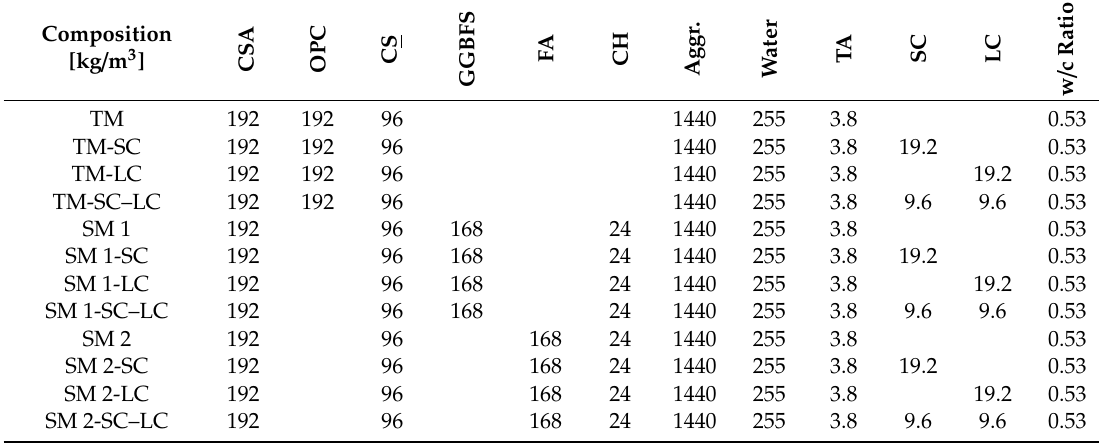
Table 1. Composition of mortars (TM: traditional CSA-based mortar, SM: sustainable CSA-based mortars, SC: sodium carbonate, LC: lithium carbonate).